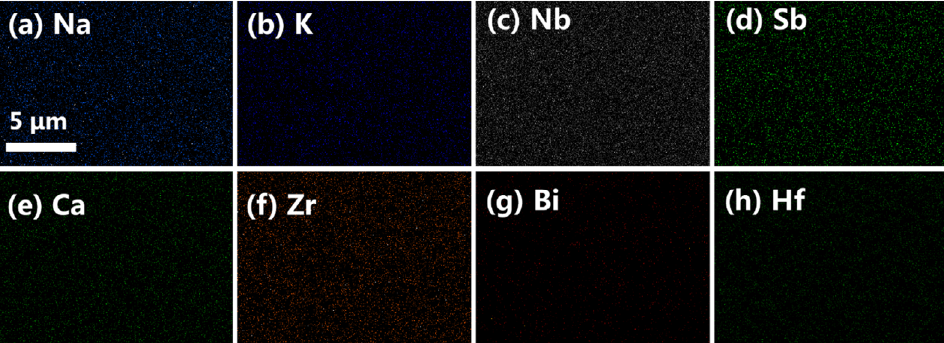
Fig. 5 Element mappings of the rectangular region in Fig.